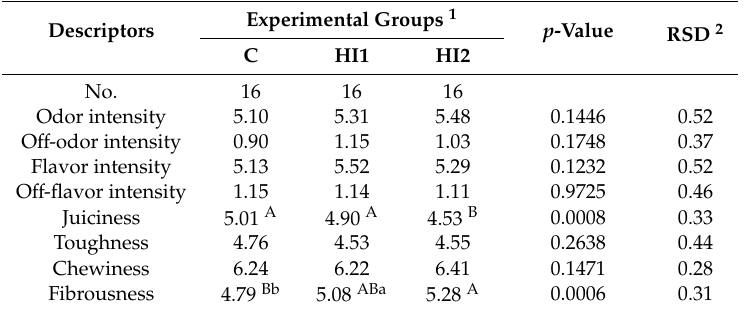
Table 6. E ff ect of the dietary inclusion of Hermetia illucens dried larvae farmed on di ff erent growth substrates (HI1, HI2) on the sensory scores of broiler quails’ breast meat.